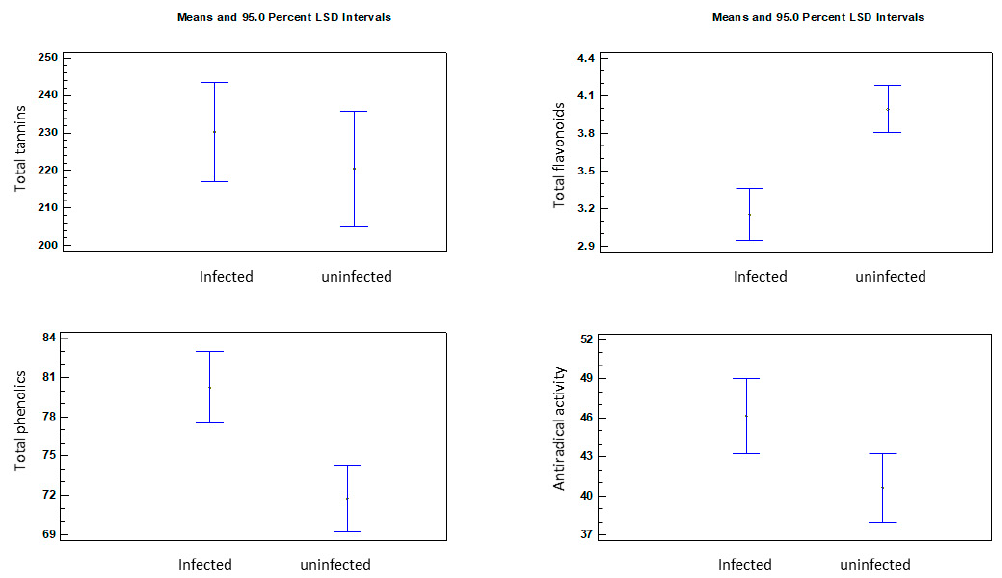
Figure 2. Results of multivariate variance for leaf condition as a factor.